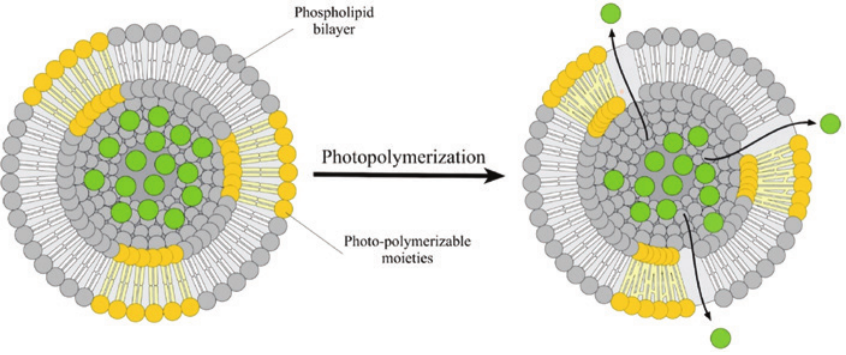
Figure 3: Schematic of light-activated polymerization of liposomes, leading to the release of